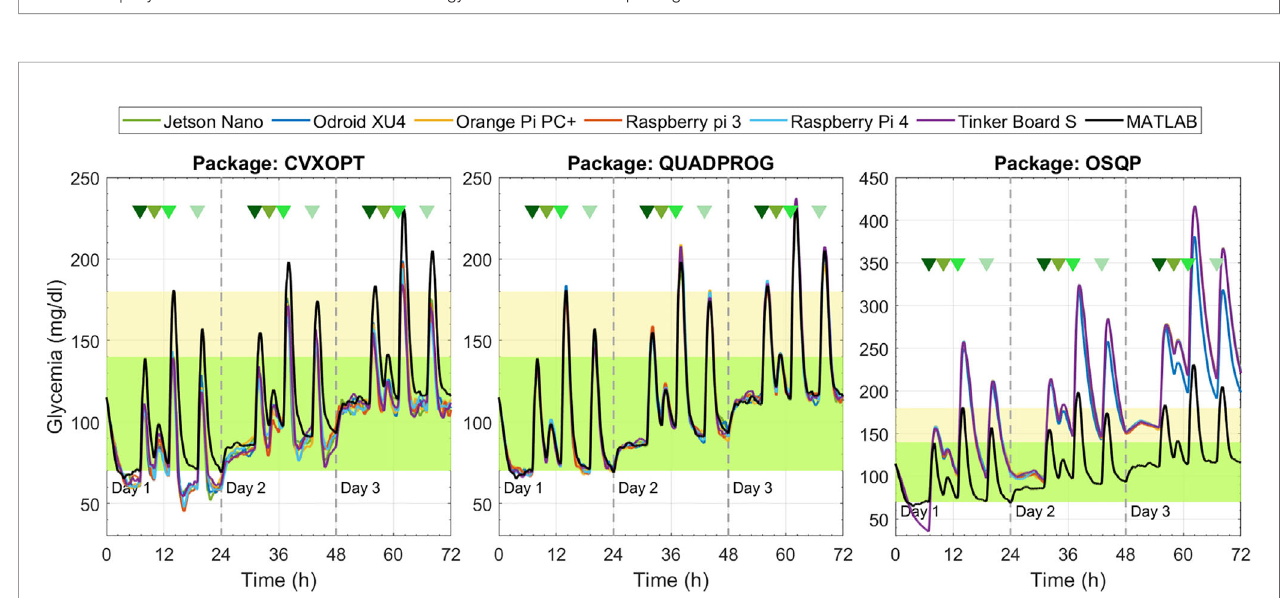
FIGURE 7 | Glycemia evolution under the ZMPC-AV strategy with the three solver